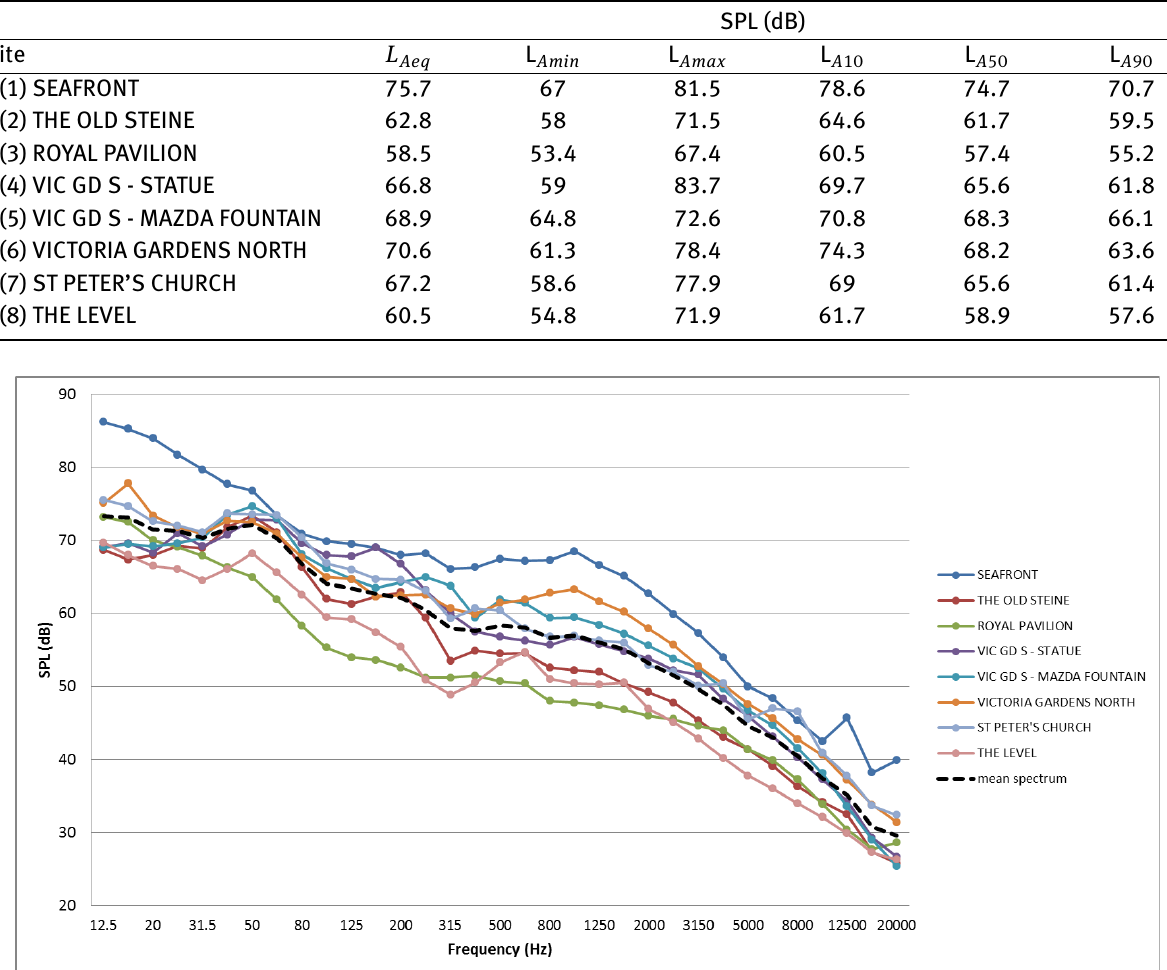
were used, namely, pleasant (PL), annoying (AN), event- ful (EV), uneventful (UN), calm (CM), monotonous (MN), vibrant (VB), and chaotic